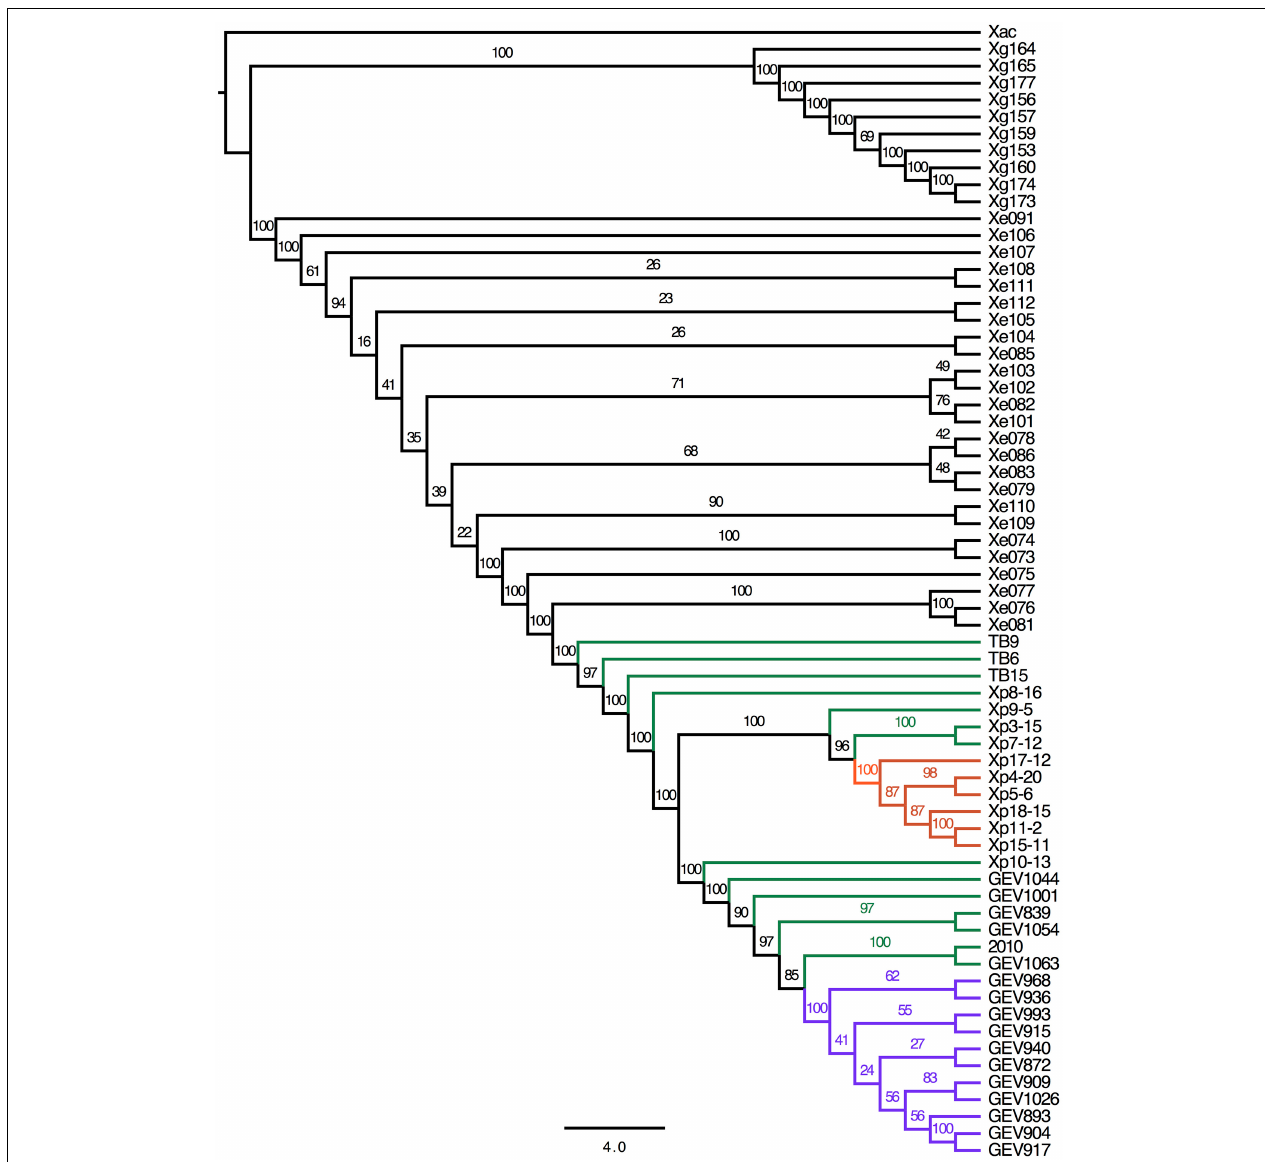
FIGURE 2 | Phylogeny based on whole genome SNP analysis. Sequencing reads were mapped to Xanthomonas axonopodis pv. citri (Xac) reference number NC_003919 and bootstrap values are displayed. Scale bar